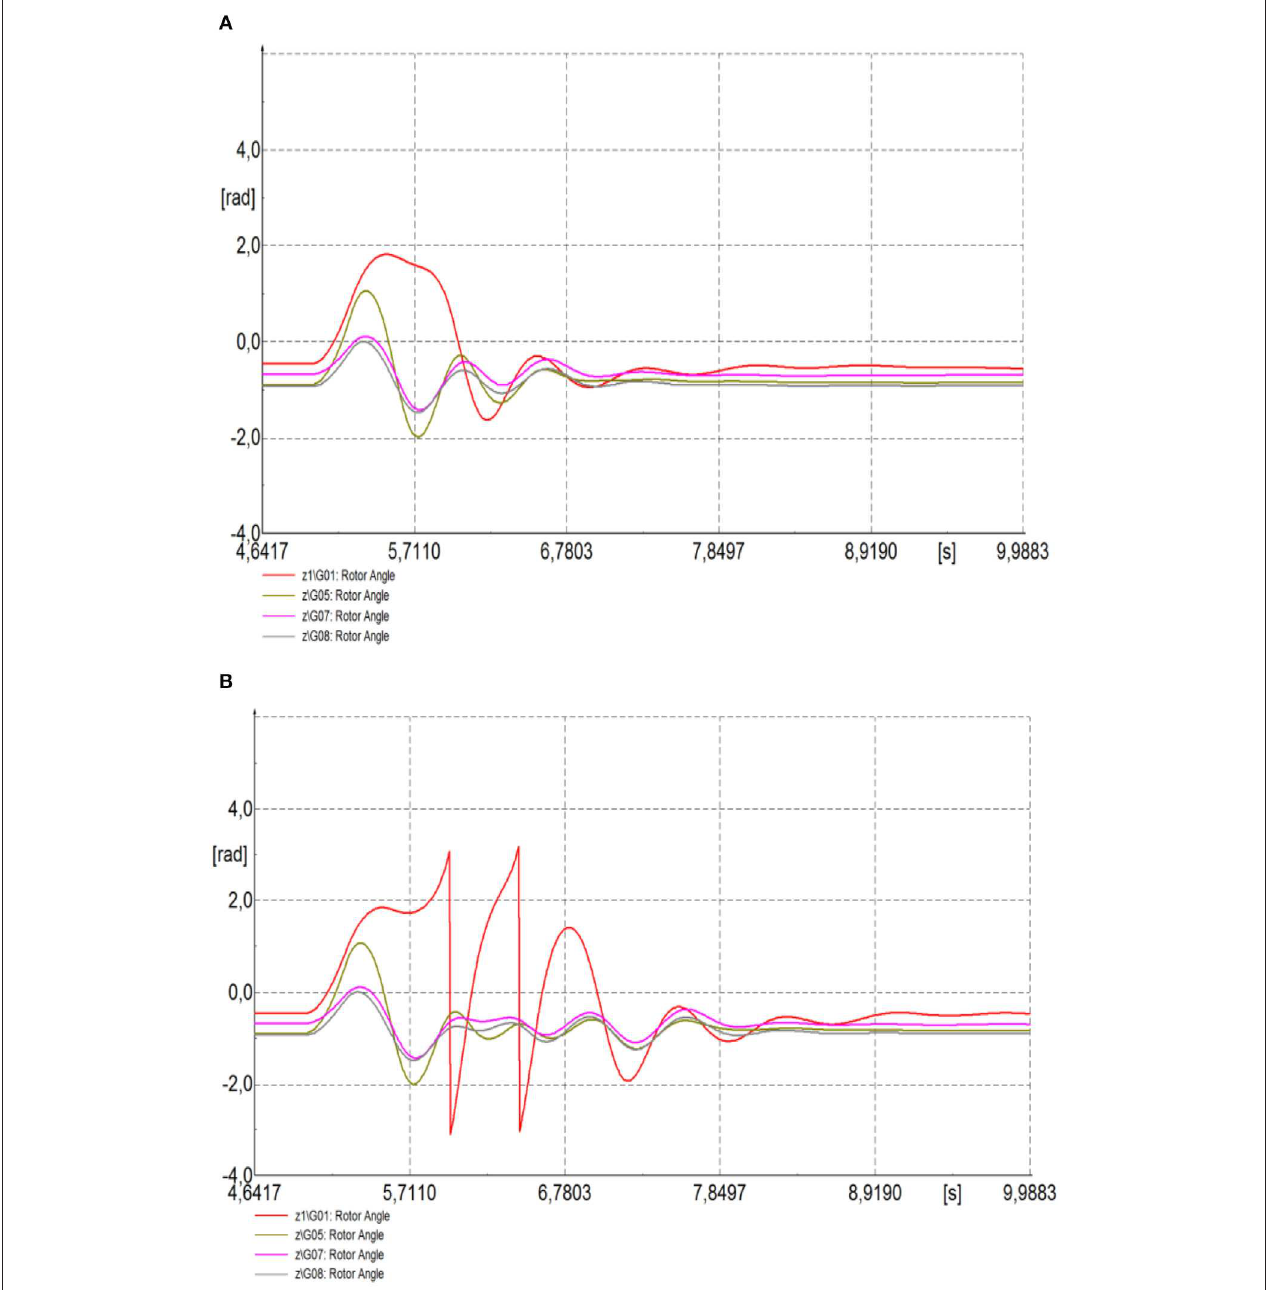
FIGURE 13 | G1 angle: (A) fault duration of 0.271s; (B) fault duration of 0.272s.